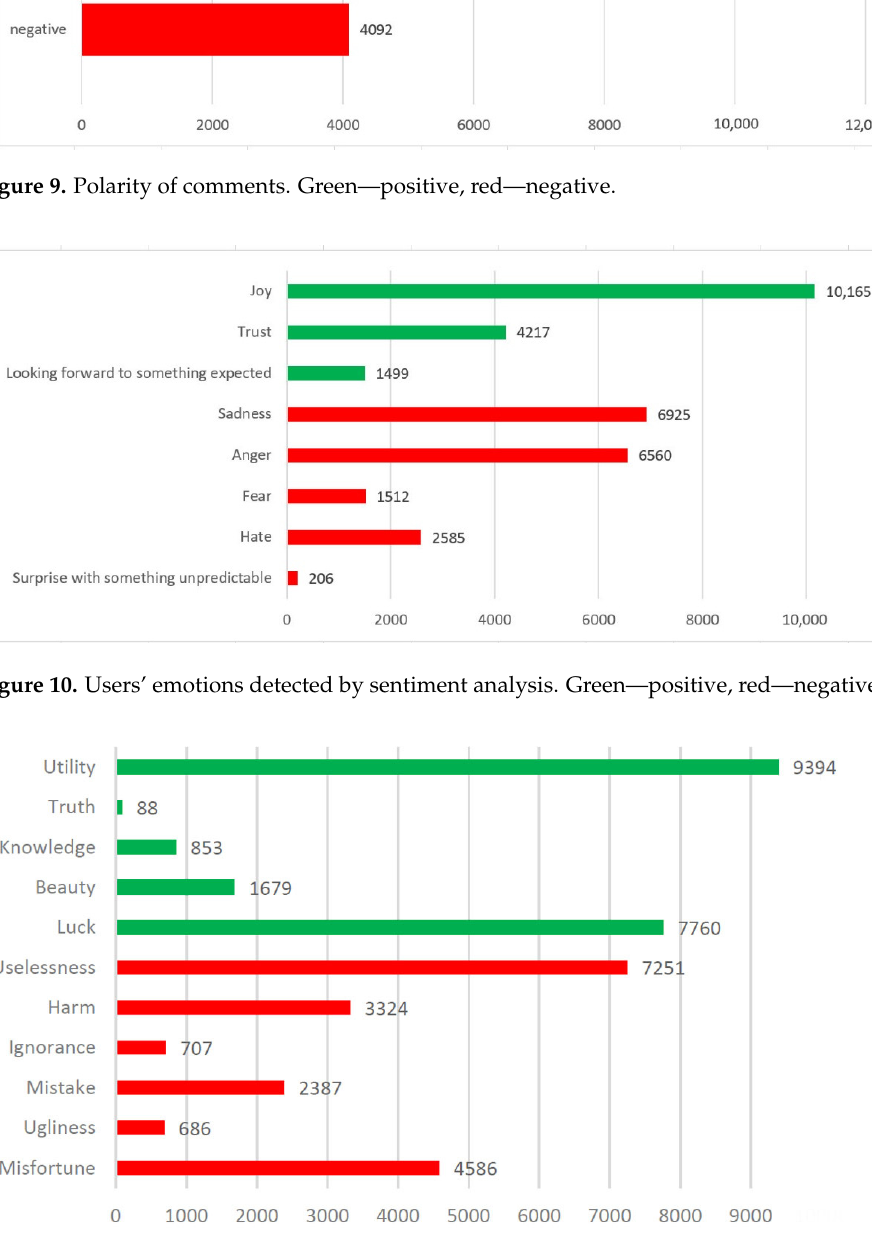
Figure 11. Positive and negative features of car-sharing services detected by sentiment analysis. Green—positive, red—negative.